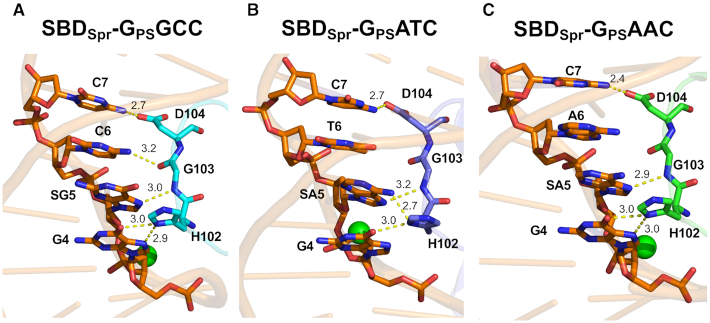
Comparison of HGD motif of SBDSpr interaction with three DNA core sequences of (A) GPSGCC, (B) GPSATC and (C) GPSAAC. SG5 and SA5 represents the nucleoside G5 and A5 with PT modification. The base contact motif HGD of SBDSpr in the three complexes was shown in cyan, purple and green, respectively.